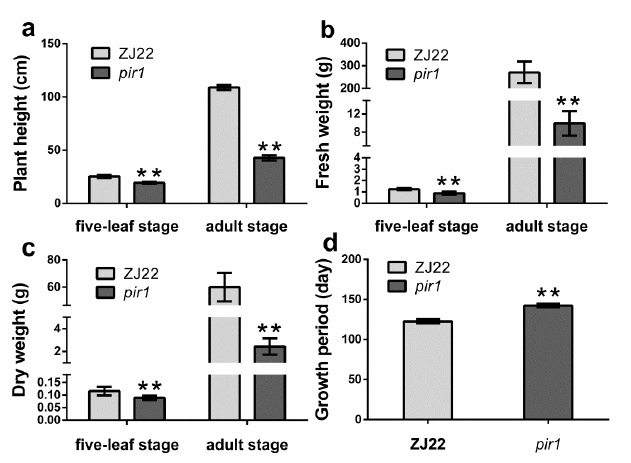
Figure 1. Comparison of agronomic traits between wild type ZJ22 and mutant PCD-induced-resistance 1 ( pir1 ). ( a ) Plant height; ( b ) fresh weight; ( c ) dry weight; ( d ) growth period. Values are means ± SD of 15 plants, ** indicated significant di ff erences at p < 0.01 determined by